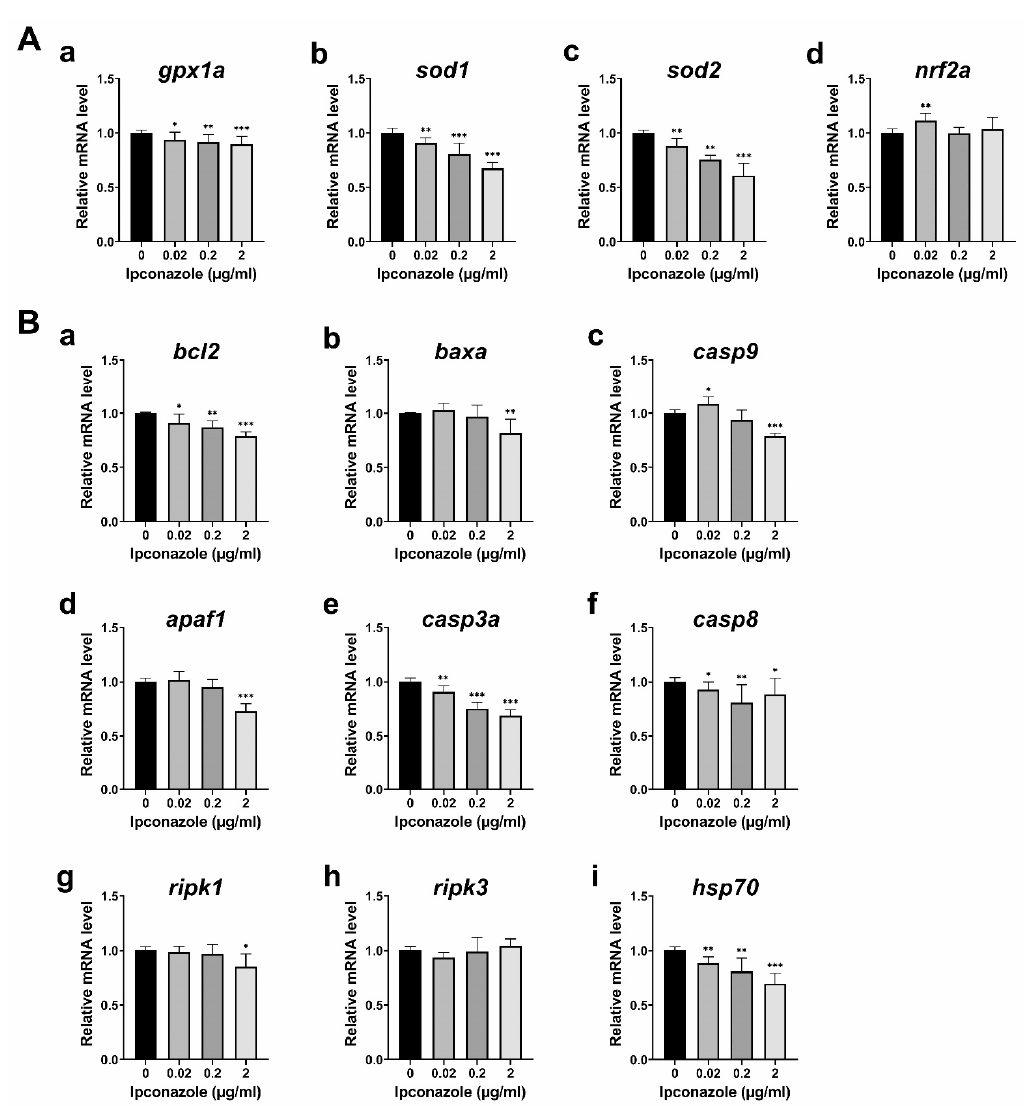
Figure 3. Ipconazole reduces expressions of antioxidant enzymes, caspases, and hsp70. ( A ) RT-PCR (real-time PCR) shows the antioxidant genes were reduced in the 28-hpf embryos treated with ipconazole at 0, 0.02, 0.2, and 2 µ g/mL: gpx1a ( a ), sod1 ( b ) sod2 ( c ), and nrf2 ( d ); ( B ) mRNA expression of the apoptotic genes, bcl2 ( a ), baxa ( b ), casp9 ( c ), apaf1 ( d ), casp3a ( e ), and casp8 ( f ), and the necroptotic genes, ripk1 ( g ) and ripk3 ( h ), as well as the molecular chaperon hsp70 ( i ) were monitored. * p < 0.05, ** p < 0.01, *** p <